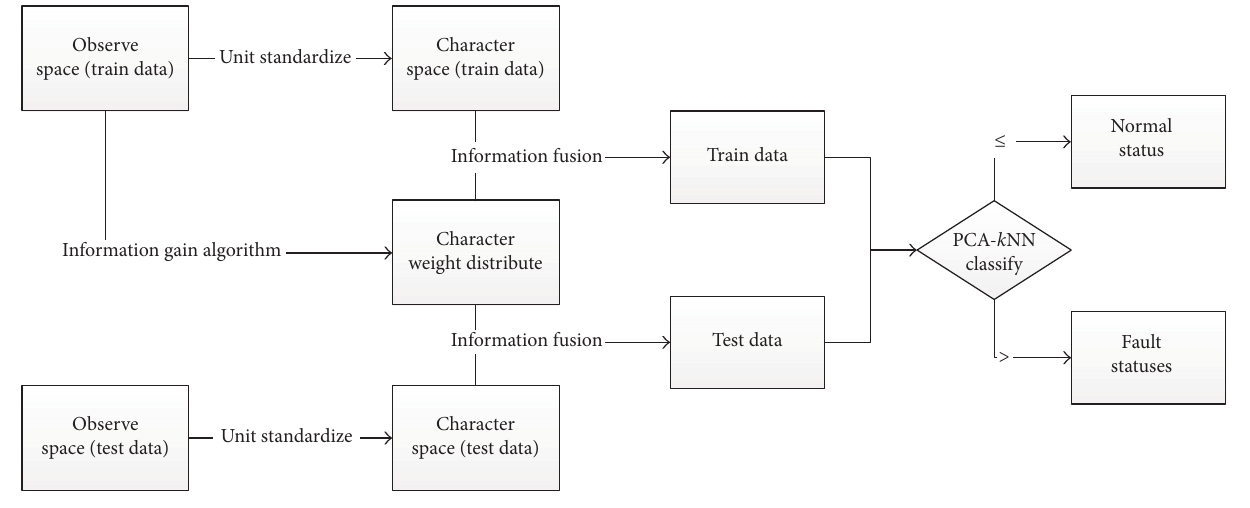
Figure 1: InEnRPCA algorithm